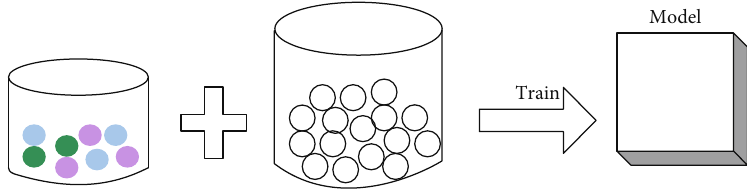
Figure 3: Semisupervised learning example.